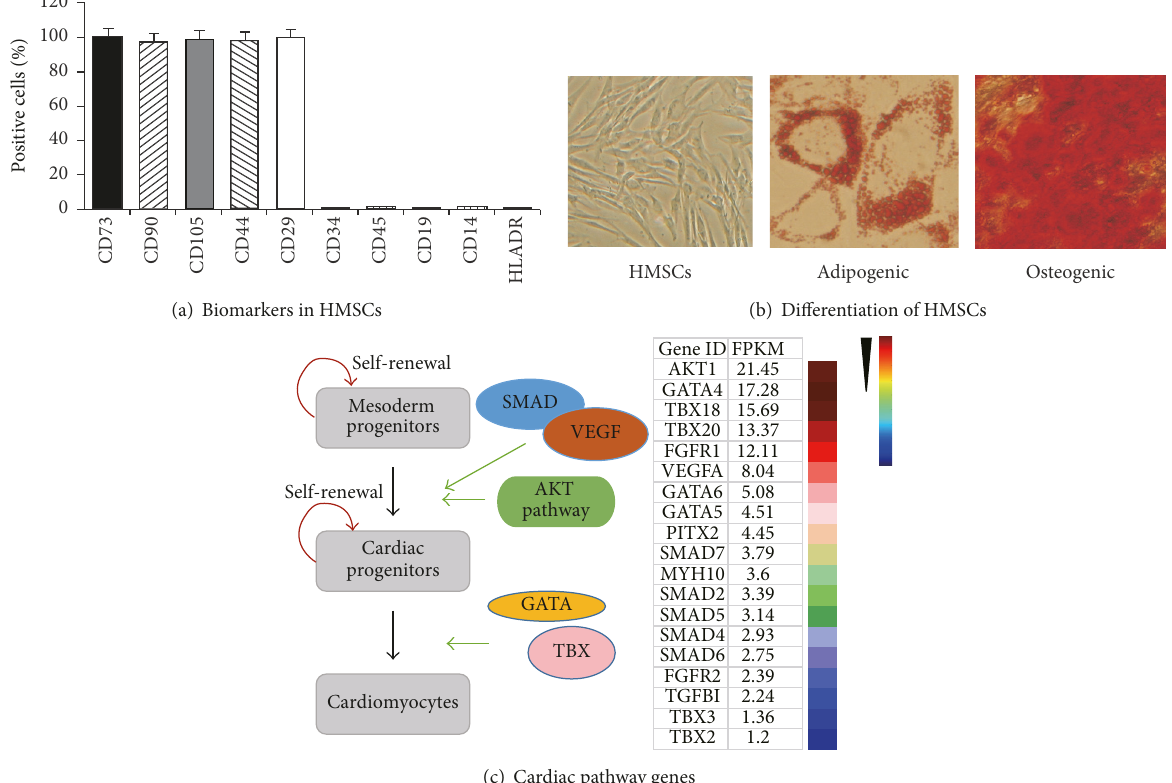
Figure 1: Characterization of human fetal heart-derived mesenchymal stem cells (HMSCs). (a) The profile of stem cell markers in cultured HMSCs. Immunophenotypes of MSCs were determined by flow cytometry using labeled antibodies specific for the indicated human surface antigens. (b) Differentiation potential of HMSCs. Cells were stained by Alizarin Red for calcium deposits during osteogenic differentiation. Adipogenic differentiation was detected by Oil Red O staining (200x). (c) The “molecular memory of cardiac origin” of HMSCs. Left panel: schematic diagram of the published cardiac stem cell pathways [4–8]. Right panel: expression of pathway genes in HMSCs. Total RNAs were isolated from HMSCs for RNA-Seq using a HiSeq4000 (Illumina). Colors represent from high (red) to low (blue) expression based on normalized FPKM values for each